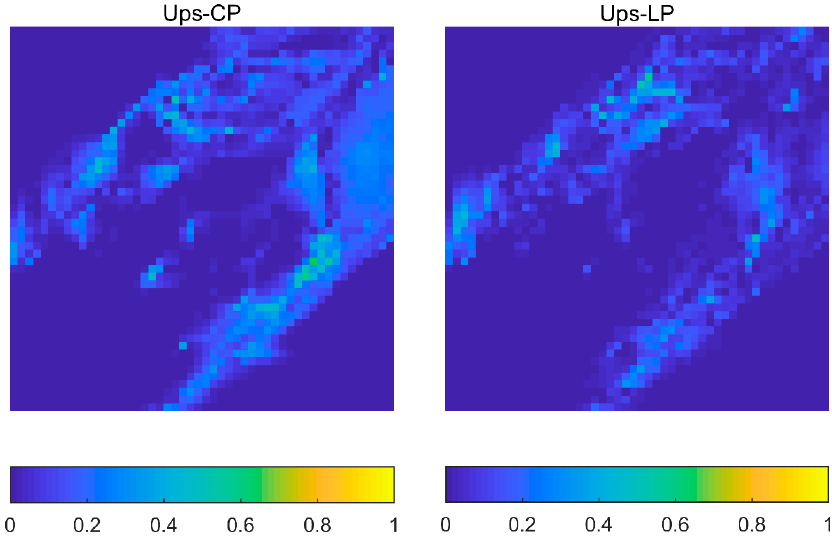
Figure 14. Case 2: relative error of pressure solutions for Ups-CP ( left ) and Ups-LP ( right ).